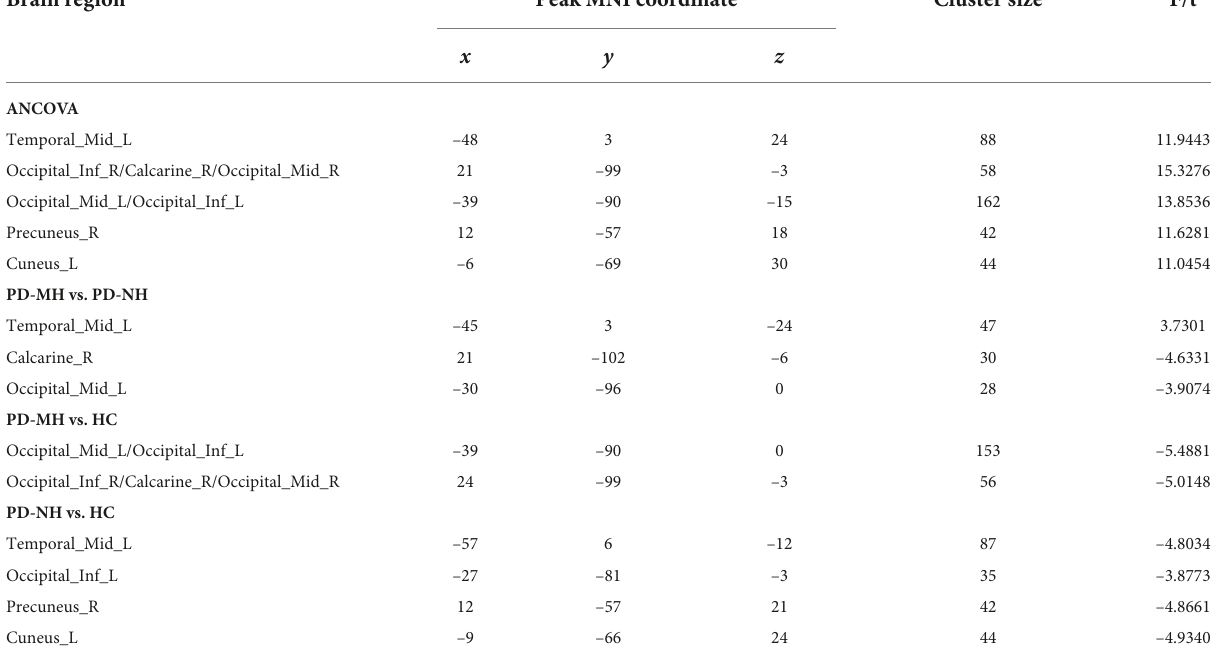
TABLE 3 Comparison of functional connectivity in PD-MH group, PD-NH group, and HC group.